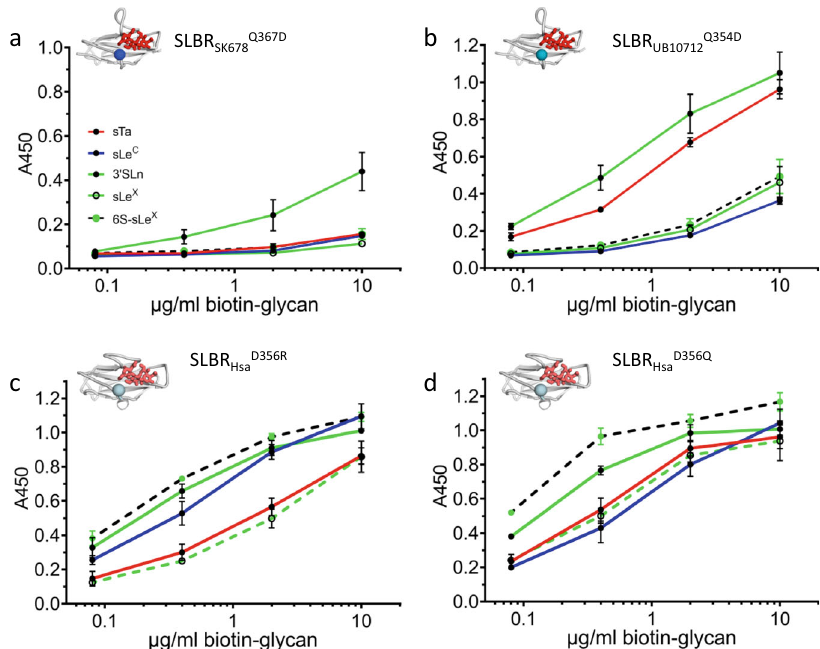
Fig. 8 Binding selectivity of FG loop variants in SLBR SK678 , SLBR UB10713 , and SLBR Hsa . Dose response curves of biotin-glycan binding to immobilized variant SLBRs (500 nM). Both a the GST-SLBR SK678 Q367D variant and b the GST-SLBR UB10712 Q345D variant have substantially reduced binding to the fucosylated ligands sLe X and 6S-sLe X . In SLBR Hsa, charge reversal or neutralization at this same position was assessed in c GST-SLBR Hsa D356R and d GST- SLBR Hsa D356Q . Both variants had increased binding to 6S-sLe X , 3 ’ sLn, and sLe X and decreased binding to sTa, albeit to somewhat different extents. Measurements were performed using 500 nM of immobilized GST-SLBR and the indicated concentrations of each ligand are shown as the mean ± SD ( n = 3 independent experiments with a single protein preparation). Statistical comparisons of ligand af fi nity between FG mutants and parent SLBR can be found in Supplementary Fig. 18. Source data are provided as a Source Data fi